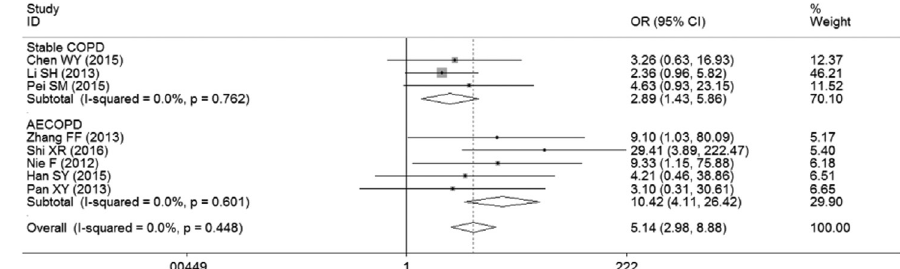
Figure 3. Forest plots of subgroup analysis of stable COPD versus AECOPD for clinical efficacy. The results are presented as individual and pooled ORs and 95% CIs. AECOPD = acute exacerbation of COPD; CI = confidence interval; COPD = chronic obstructive pulmonary disease; OR = odds